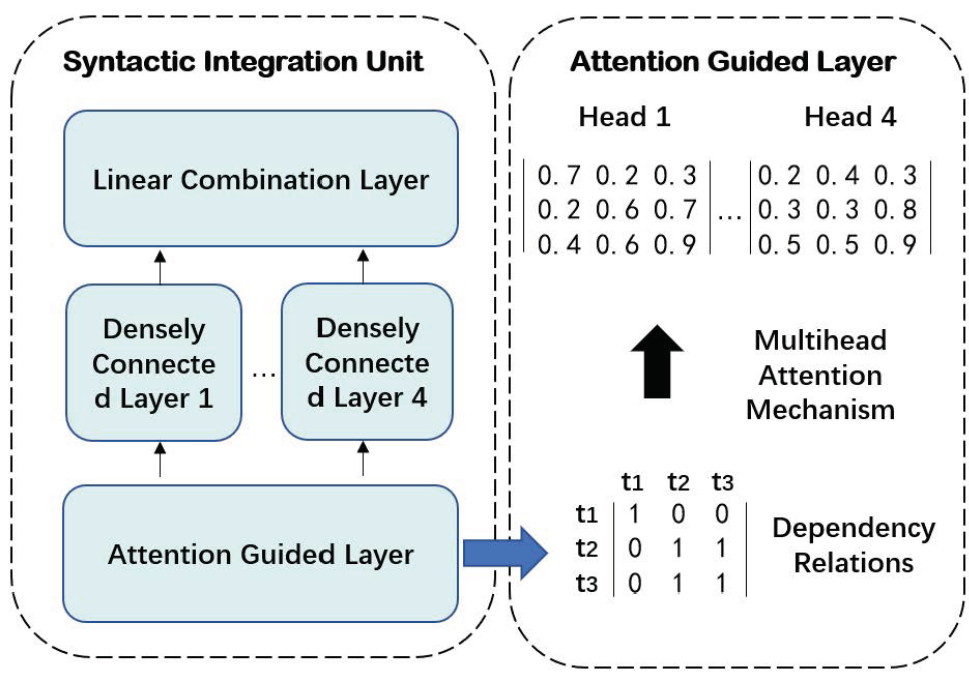
Figure 3. The structure in Syntactic Integration